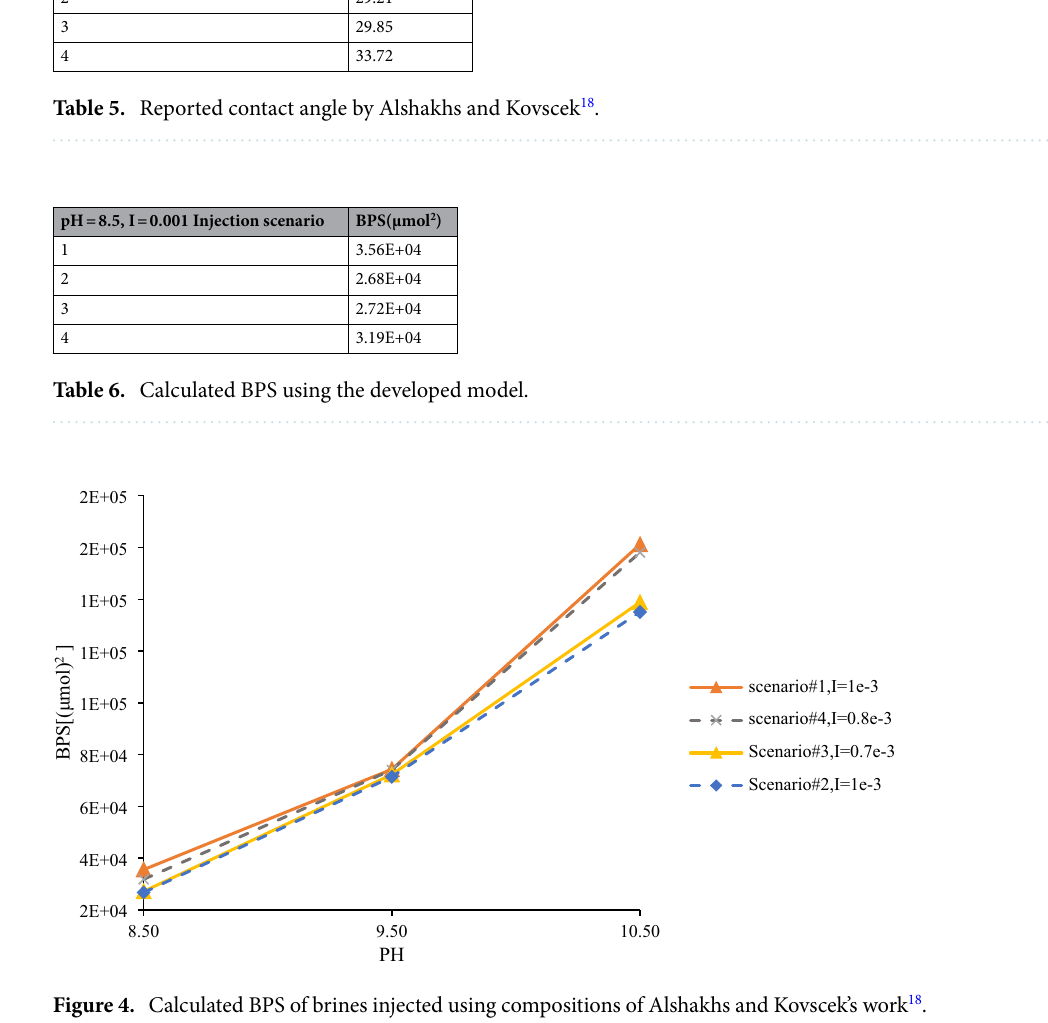
Figure 4. Calculated BPS of brines injected using compositions of Alshakhs and Kovscek’s work 18